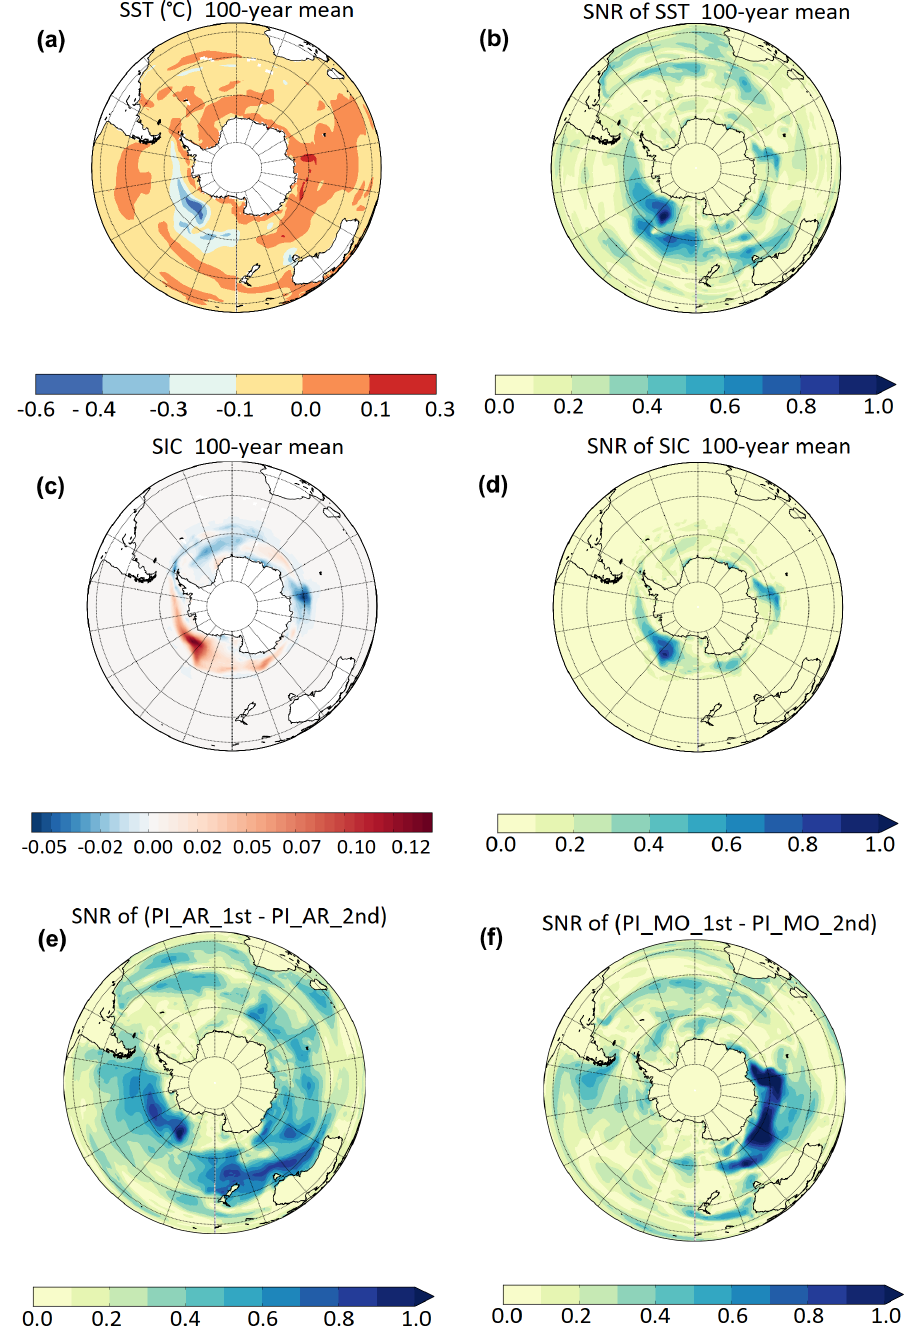
Figure 11. The 100-year means and corresponding SNR of (PI MO − PI AR ) differences for SH SST (a, b) and SH SIC (c, d) . Panels (e) and (f) show SNR of (PI AR 1st − PI AR 2nd) and (PI MO 1st − PI MO 2nd) differences for SH SST, respectively.